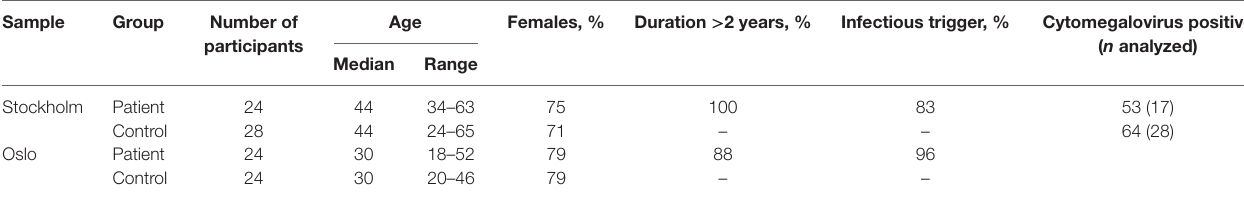
Table 1 | Participant characteristics.